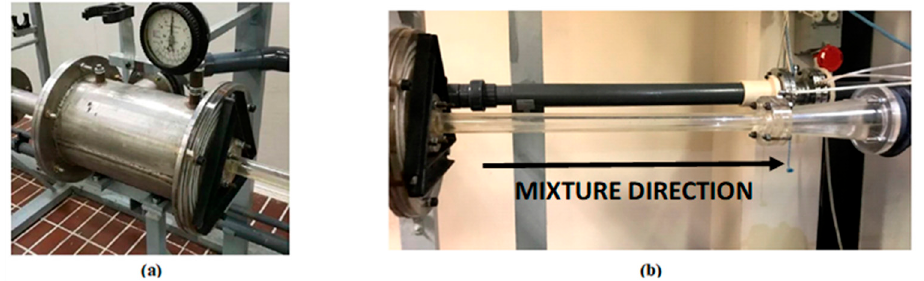
Figure 5. The ejector components analyzed in this work. ( a ) Shows the mixing chamber, which allows the mixing and exchange of energy and momentum between motive fluid and sucked fluid; ( b ) the diverging diffuser, which slows down the fluid mixture and contributes to a partial pressure recovery of the fluid current.